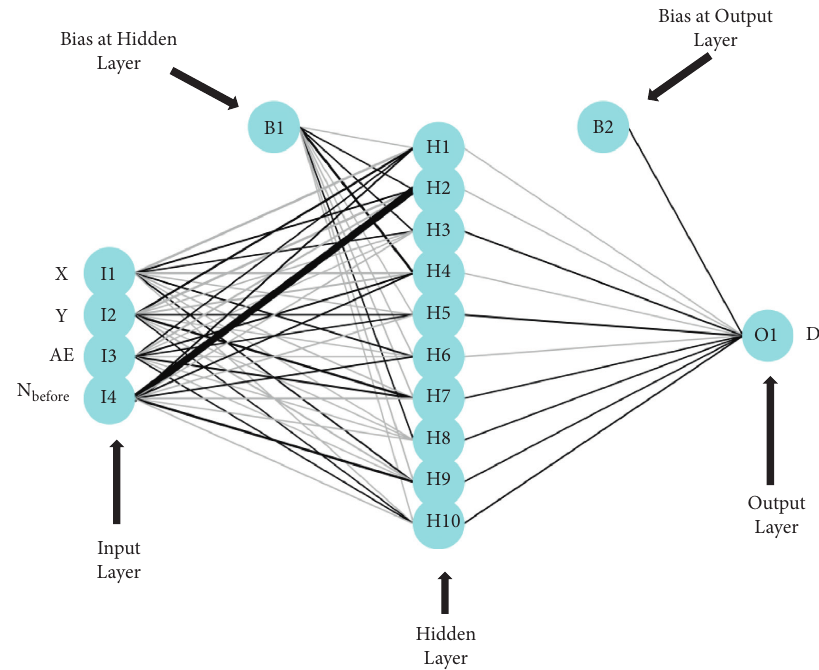
Figure 3: Architecture of optimal ANN model for degree of improvement DI